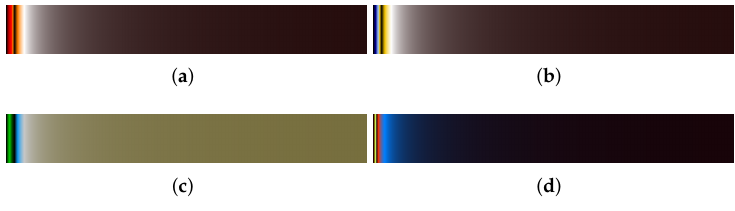
Figure 4. Colour maps used in the